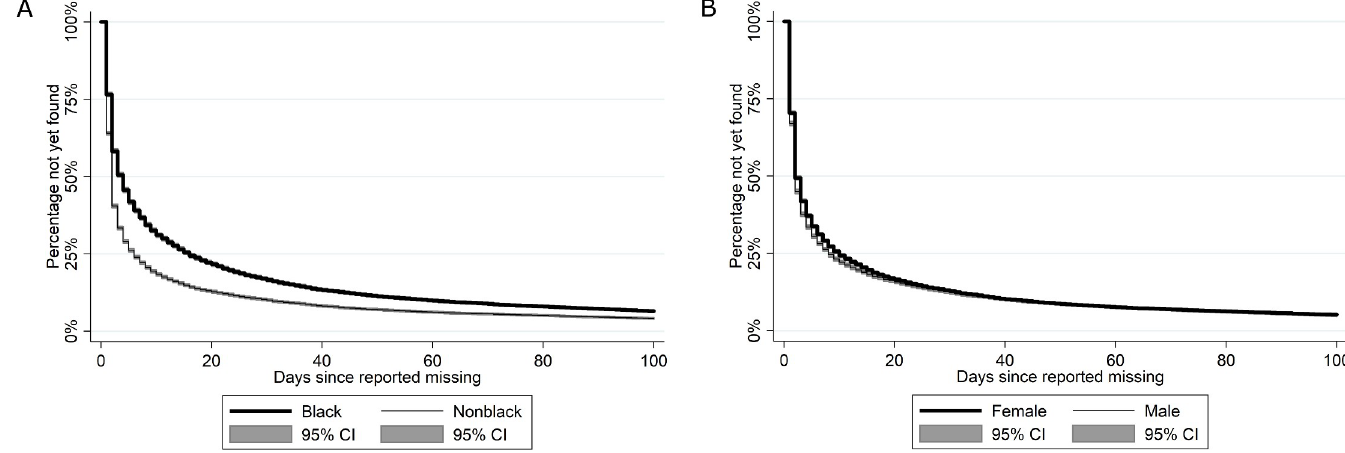
Fig 2. Percentage not yet found by race, gender, and number of days missing.